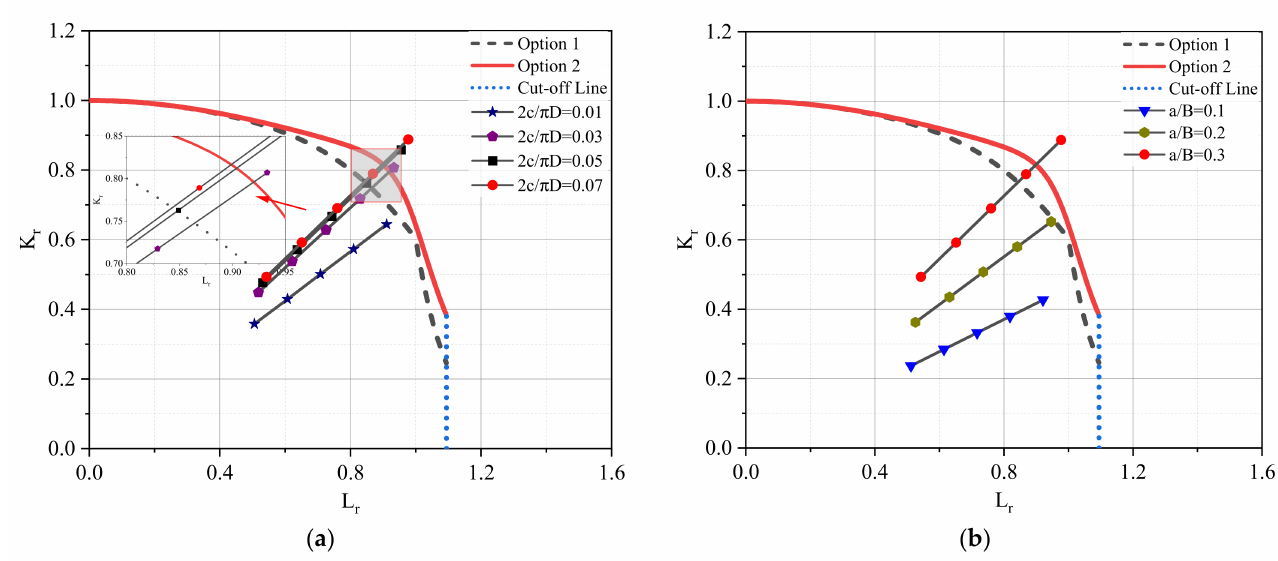
Figure 7. Effect of crack size on the evaluation results of Ø813 × 17.5 mm pipeline girth welded joints. ( a ) a/B = 0.3; ( b ) 2 c/ π D =